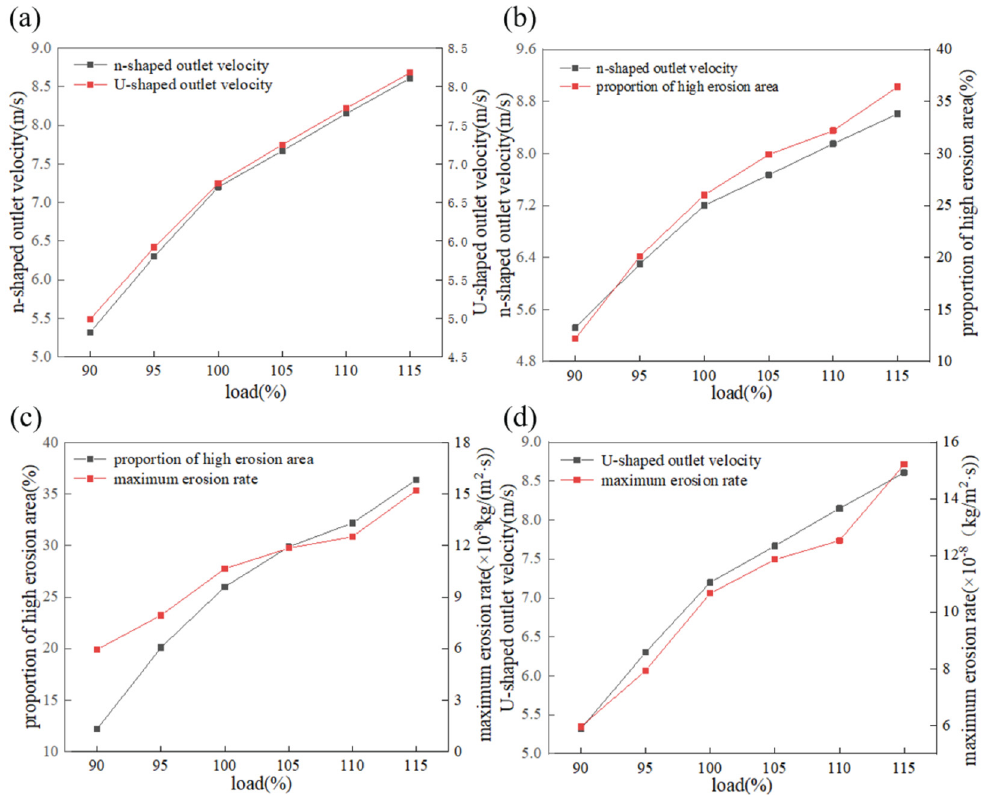
Fig. 10. Result data processing